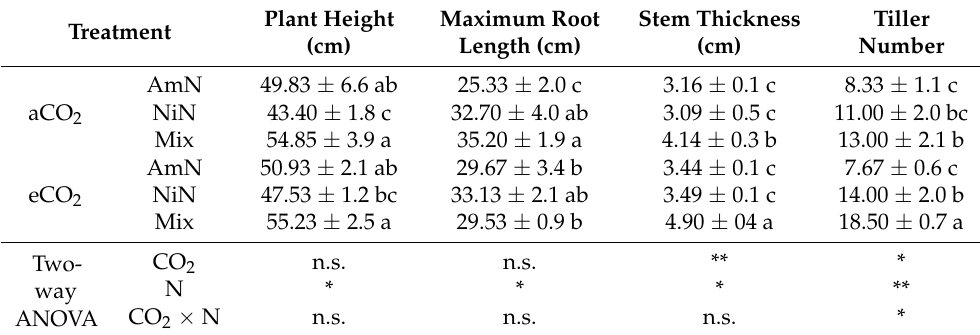
Table 2. Agronomic traits for wheat